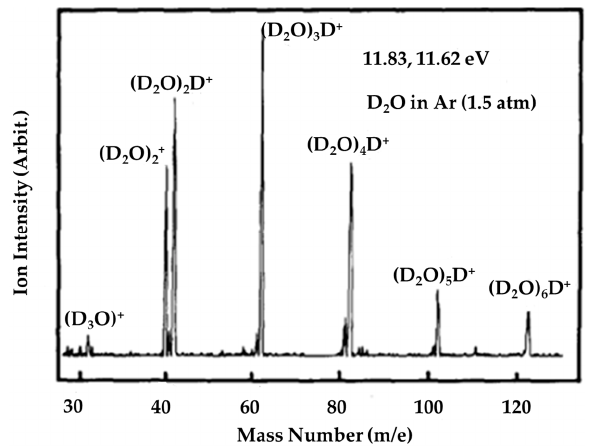
Figure 8. Ar lamp (LiF window; 11.83 and 11.62 eV) photoionization mass spectrum of heavy water clusters (D 2 O)n with unit mass resolution. Conditions: 1.5 atm total stagnation pressure (seeded in Ar). Figure adapted from [10] with permission. Copyright 1986 American Institute of Physics.